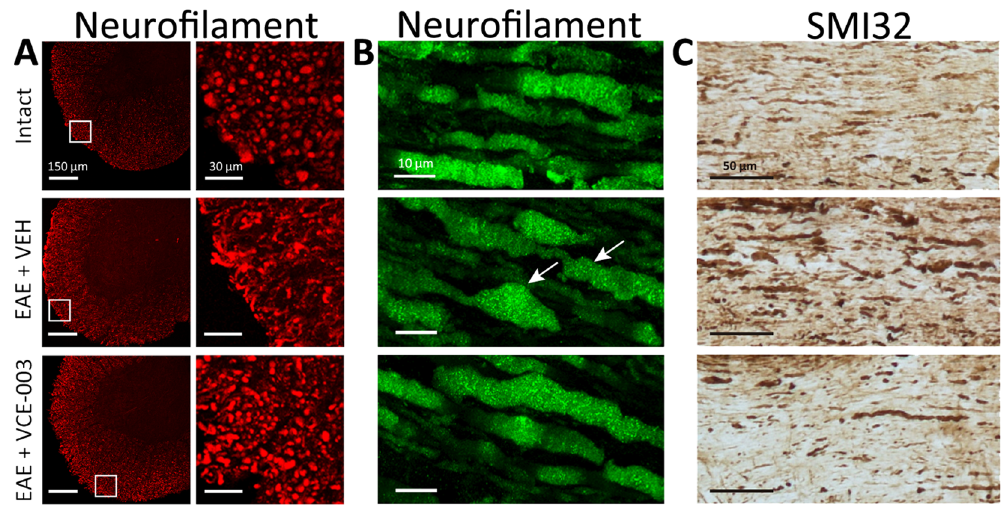
Figure 6. VCE-003 reduces axon damage. Representative images of axon morphology changes: (A) transversal thoracic spinal cord sections, neurofilament staining in red; (B) longitudinal thoracic spinal cord sections, neurofilament staining in green (please note axon swelling, arrows). (C) VCE-003 treatment helps to preserve the axon structure as showed in longitudinal thoracic spinal cord sections by SMI32 staining.